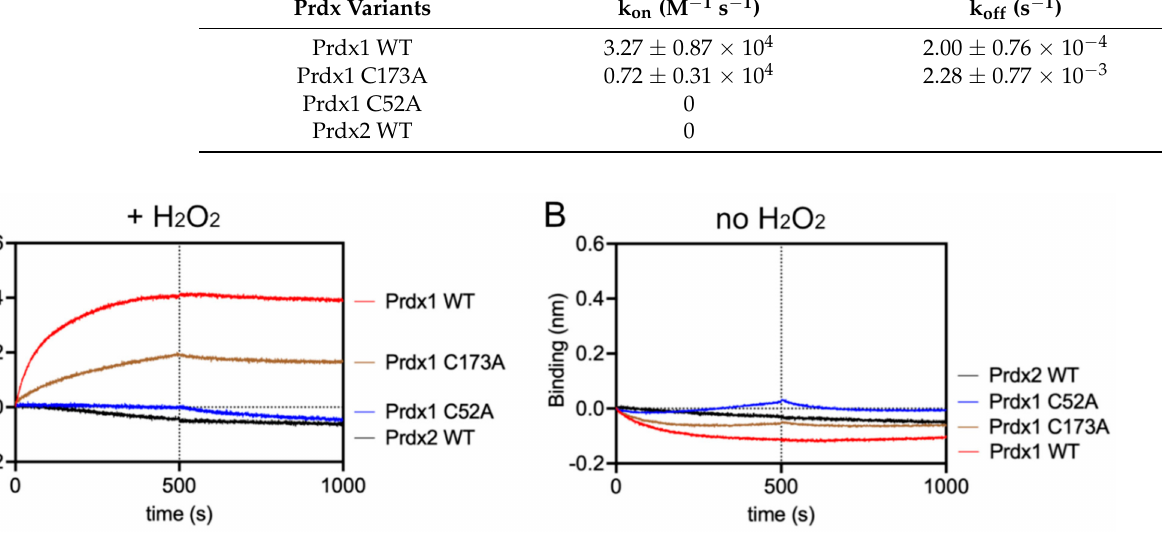
Figure 4. Prdx1 interacts with ASK1-TBD in the presence of H 2 O 2 through its peroxidatic cysteine via disulfide bond formation, while Prdx2 does not interact with ASK1-TBD. ( A ) BLI assay in the presence of 10 µ M H 2 O 2 . ( B ) BLI assay in the absence of H 2 O 2 (to guarantee no oxidation, 10 µ M DTT was added to the buffer solution). The concentration of Prdx1 WT, C52A, C173A, and Prdx2 WT were fixed at 1 µ M and MBP was used as reference. The y -axis indicates the wavelength shift (in nm) of the Octet Red 96 instrument. The vertical dashed line separates the association and dissociation